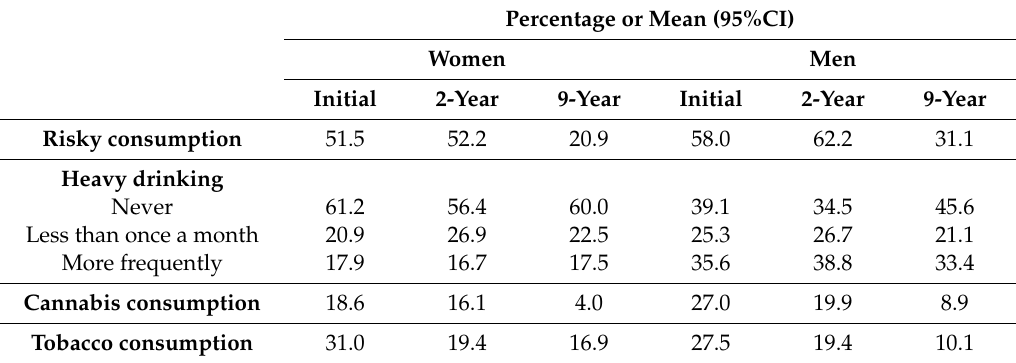
Table 2. Prevalence of alcohol, tobacco, and cannabis consumption at the beginning of the study, and at 2-year and 9-year